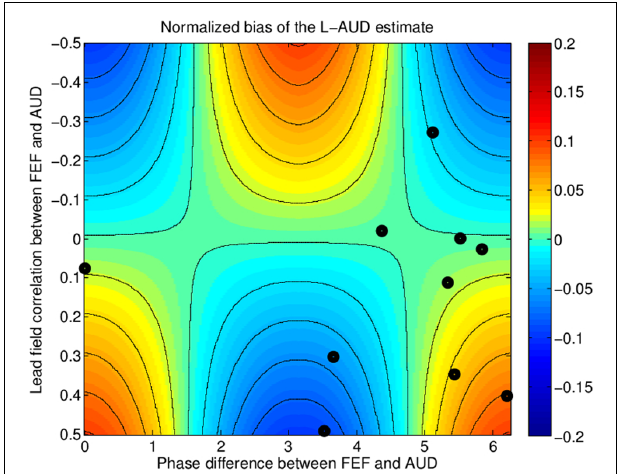
FIGURE 6 | Simulation of the bias in source strength estimation due to model mis-specification, i.e., fitting only two auditory (AUD) sources instead of three (twoAUD and one FEF). The bias depends on two parameters: (1) the overlap (inner product) between the lead-fields of the missing source and the fitted sources, plotted along the horizontal axis, which varies across subjects due to differences in brain geometry, and (2) the phase relationship between the FEF response and the AUD source response, plotted along the vertical axis.The normalized bias (relative to the true auditory source strength) in the estimated activity from auditory cortex is shown by the color-map, with hot colors indicating a positive bias (overestimation of auditory cortex activity) and cold colors indicating a negative bias (underestimation of auditory cortex activity). Estimates of the parameter values from the individual subject data are shown as black dots overlaid on the colormap. Depending on the geometry and the phase-relationship, the strength of the auditory source estimate can be biased either positively or